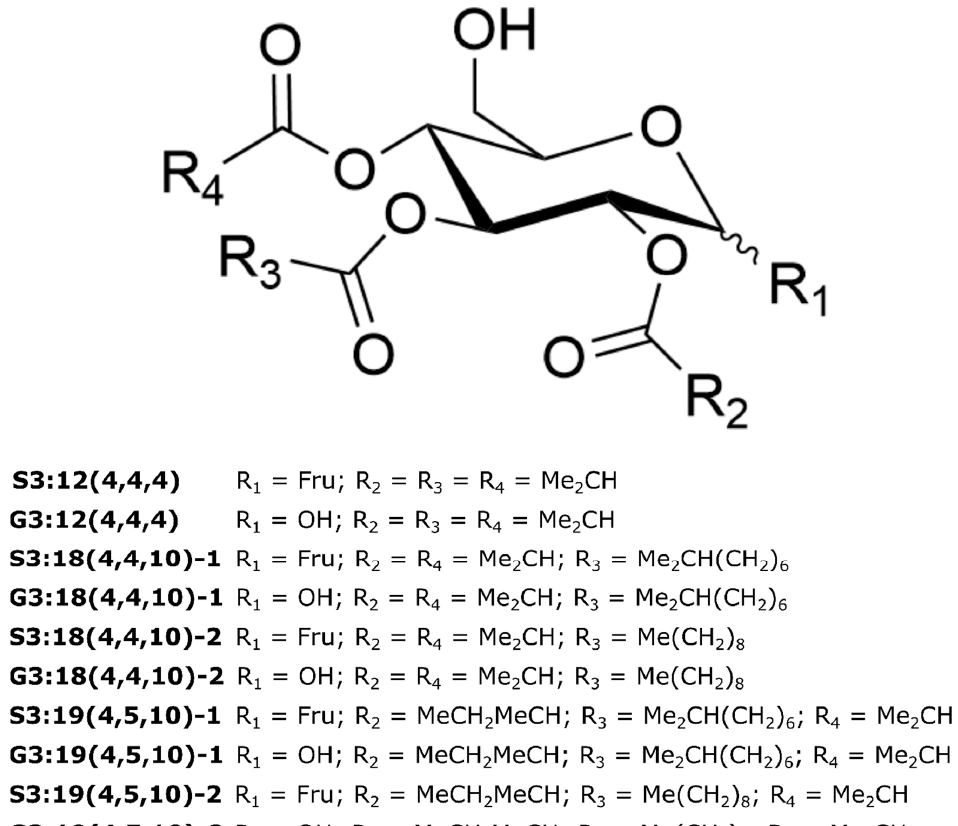
Figure 4. NMR-resolved structures of acylsugars purified from S. pennellii . For acylsucroses, the R 1 group is observed only in the α configuration. For each acylglucose, two distinct anomers are observed with group R 1 in either the α or β configuration. Fru = β -fructofuranose.